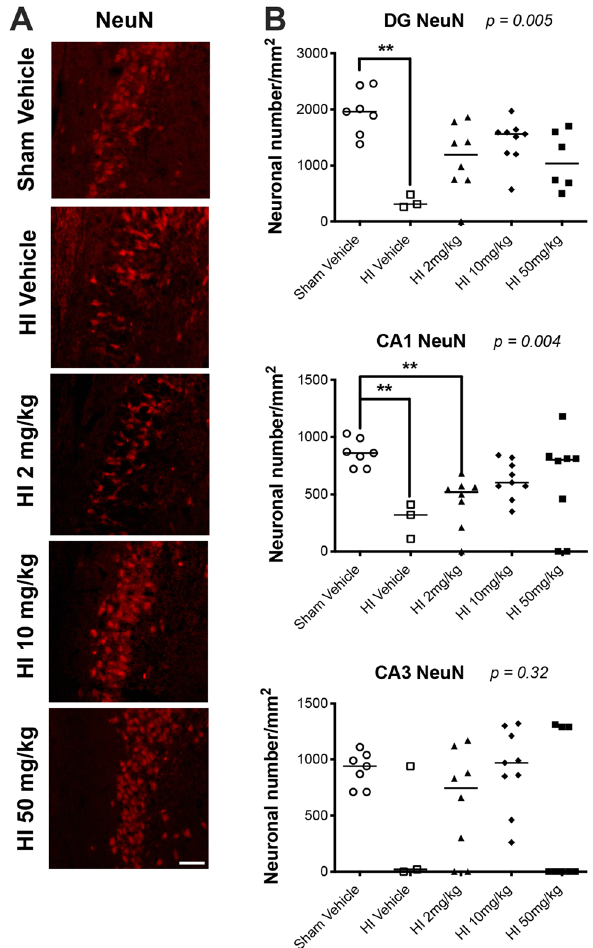
Figure 2. Immunostaining for mature neurons in sham and HI rats treated with vehicle or sildenafil. Cells were counted in three regions of the hippocampus: i.e., dentate gyrus (DG), CA1, and CA3 regions of the ipsilateral hippocampus. ( A ) Representative immunofluorescent micrographs of the mature neurons labeled with NeuN in the ipsilateral DG region of the hippocampus. ( B ) Mature neuronal cells labeled with NeuN (median with individual data points representation) in DG, CA1 and CA3. Significance: p value from Kruskal–Wallis test, with Dunn’s post-hoc comparison tests: ** p < 0.01. Number of animals: n = 7 sham vehicle, 3 HI vehicle, 8 HI 2 mg/kg, 9 HI 10 mg/kg and 8 HI 50